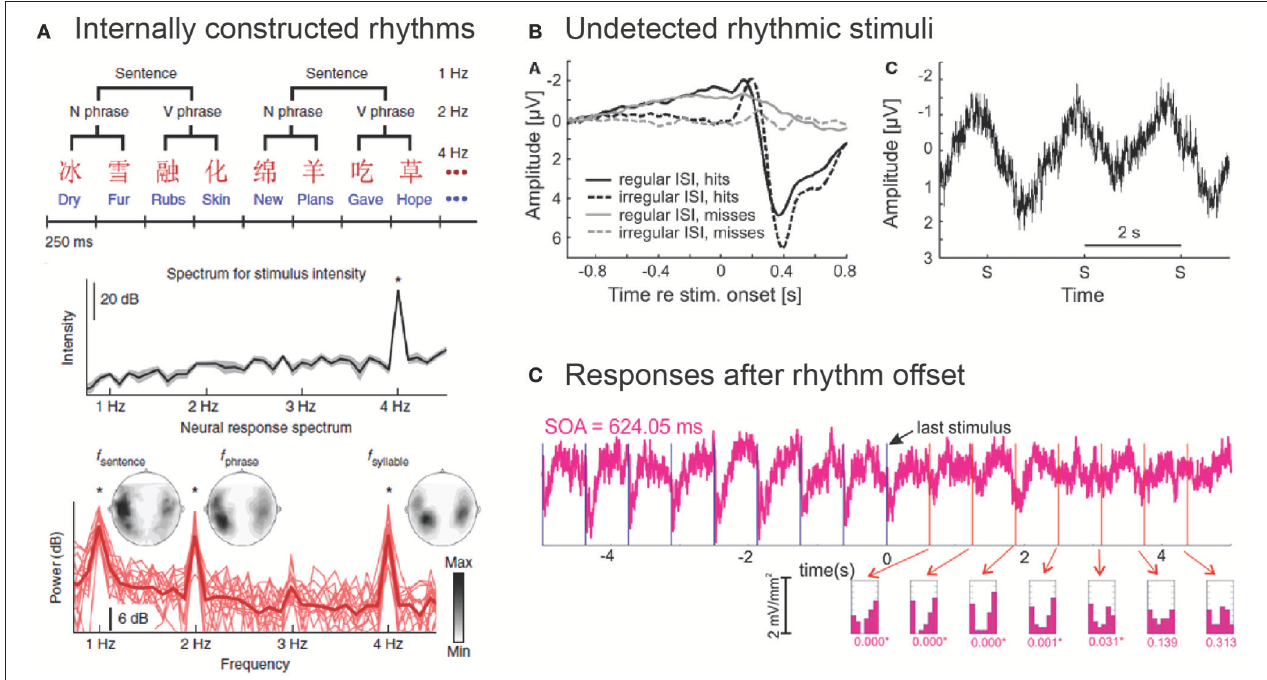
FIGURE 2 | Overview of selected studies that show endogenous oscillatory activity in the absence of measurable evoked responses. (A) Ding et al. (2016) constructed speech sentences in which not only words (4Hz) but also phrases (2Hz) and sentences (1Hz) fluctuated rhythmically (top). The spectrum of these stimuli only reflected the word rate, but not the rhythm of phrases or sentences (middle). Apart from brain responses at the frequency of words, the authors also observed neural activity fluctuating at phrase and sentence rates, even though these were not present in the stimulus spectrum (bottom). Asterisks mark frequency bins with significantly higher power than neighboring bins (see Ding et al., 2016, for details). Reproduced with permission from Ding et al. (2016). (B) In the study by Zoefel and Heil (2013), only detected but not undetected auditory stimuli produced a noticeable evoked neural response (left; no stimuli were presented during catch trials). Nevertheless, brain activity averaged across instances of three subsequently missed stimuli revealed an oscillatory pattern at stimulation frequency (right; S denotes the timing of stimulus presentation). Reproduced with permission from Zoefel and Heil (2013). (C) Lakatos et al. (2013) recorded neural activity in monkey auditory cortex during and after the presentation of rhythmic auditory stimuli. They found that, even after the offset of the rhythmic stimulus sequence, the neural phase at the time of expected stimulus occurrence (shown by vertical lines) is strongly biased toward a particular phase (see insets for a phase distribution across trials). This phenomenon was visible both in tonotopical regions tuned to the sound frequency of the stimulus (shown) and in those who are not (not shown). Reproduced with permission from Lakatos et al.